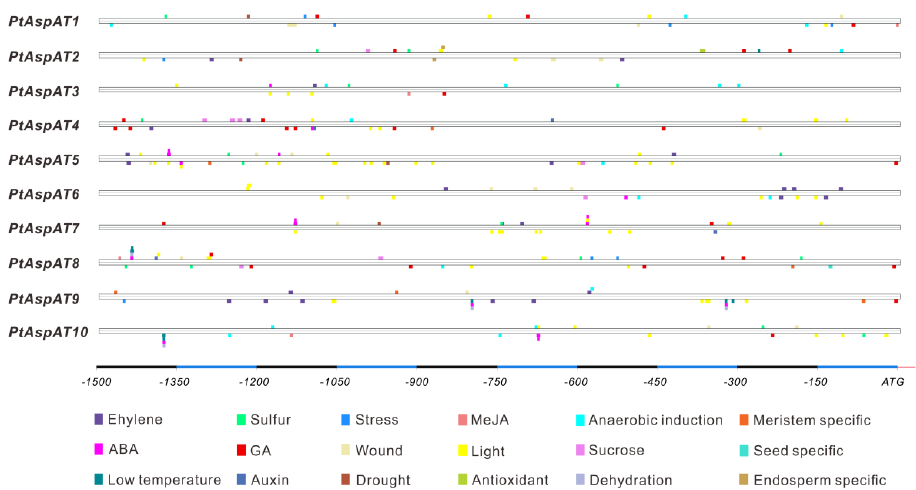
Figure 3. Prediction of the cis -regulatory elements in the promoters. Upstream 1500 bp sequences of each gene promoter were analyzed in the PlantCARE server. Stress-related cis -regulatory elements are spotted in different colors.